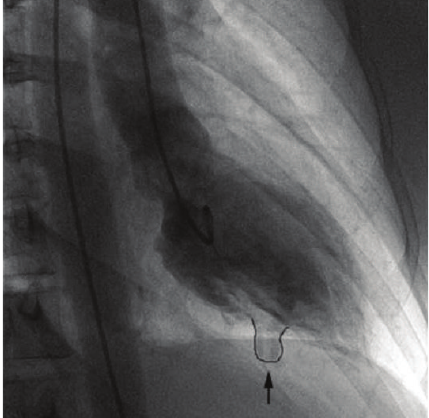
Figure 2: Left ventriculogram showing a left ventricular diverticu- lum (arrow).